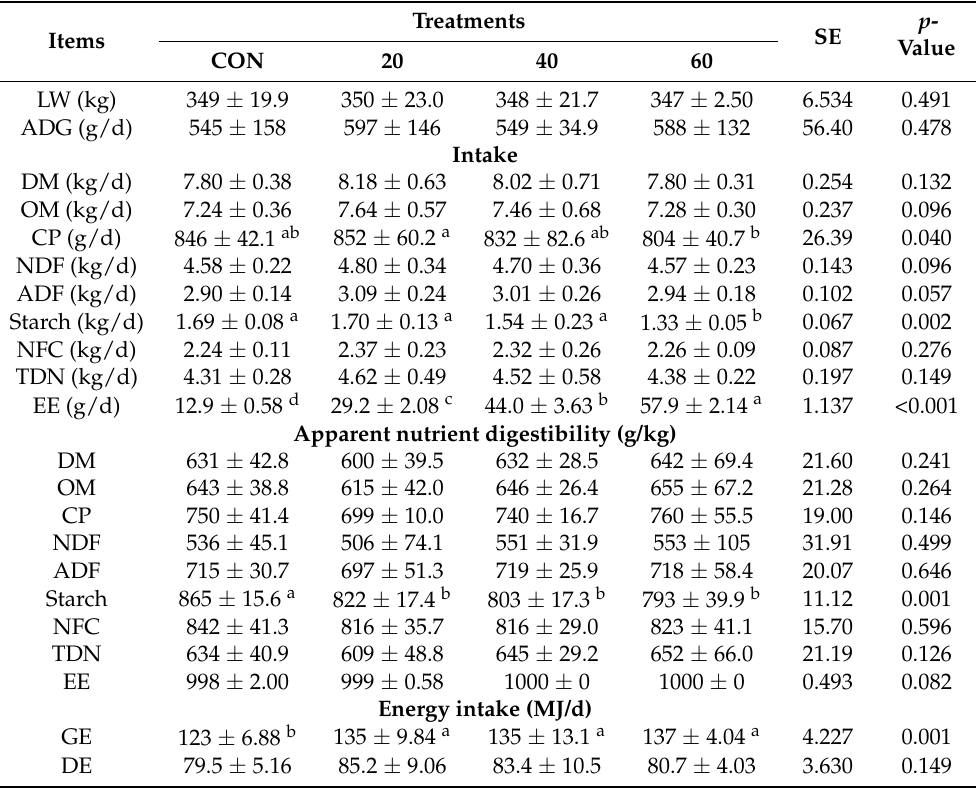
Table 4. Effect of palm oil supplementation on intake and apparent digestibility in